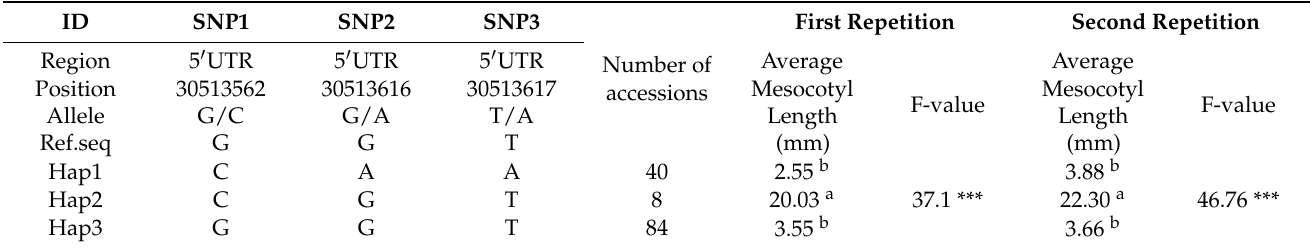
Table 3. Results of haplotype analysis of Os01g0731100 .